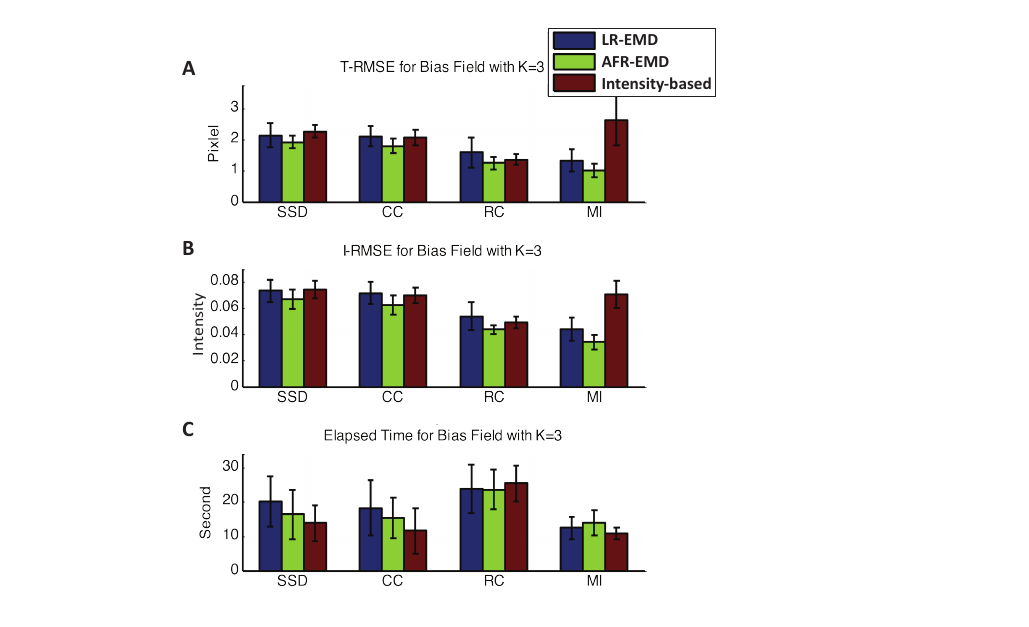
Figure A1. Registration performance in the presence of three Gaussian kernels. Mean and variance of T-RMSE and I-RMSE for images in BrainWeb dataset are shown in ( A , B ) panels. ( C ) panel compares the running time for all methods.